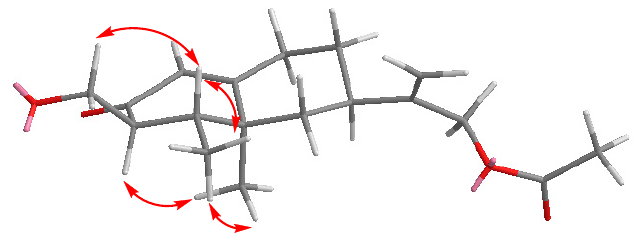
Figure 5. Selected NOEs observed for compound 21.